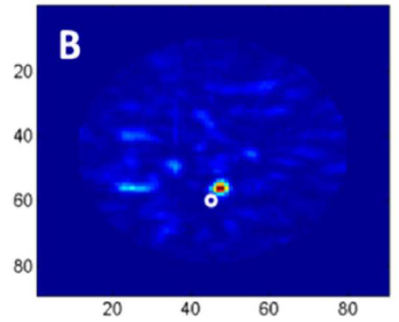
Figure 26. Reconstructed images of a rubber breast phantom obtained using the system developed by Santorelli et al. [82]. Reprinted with permission from